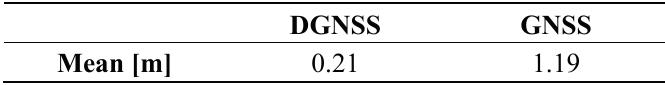
Table 2. Average deviations from the straight line path.